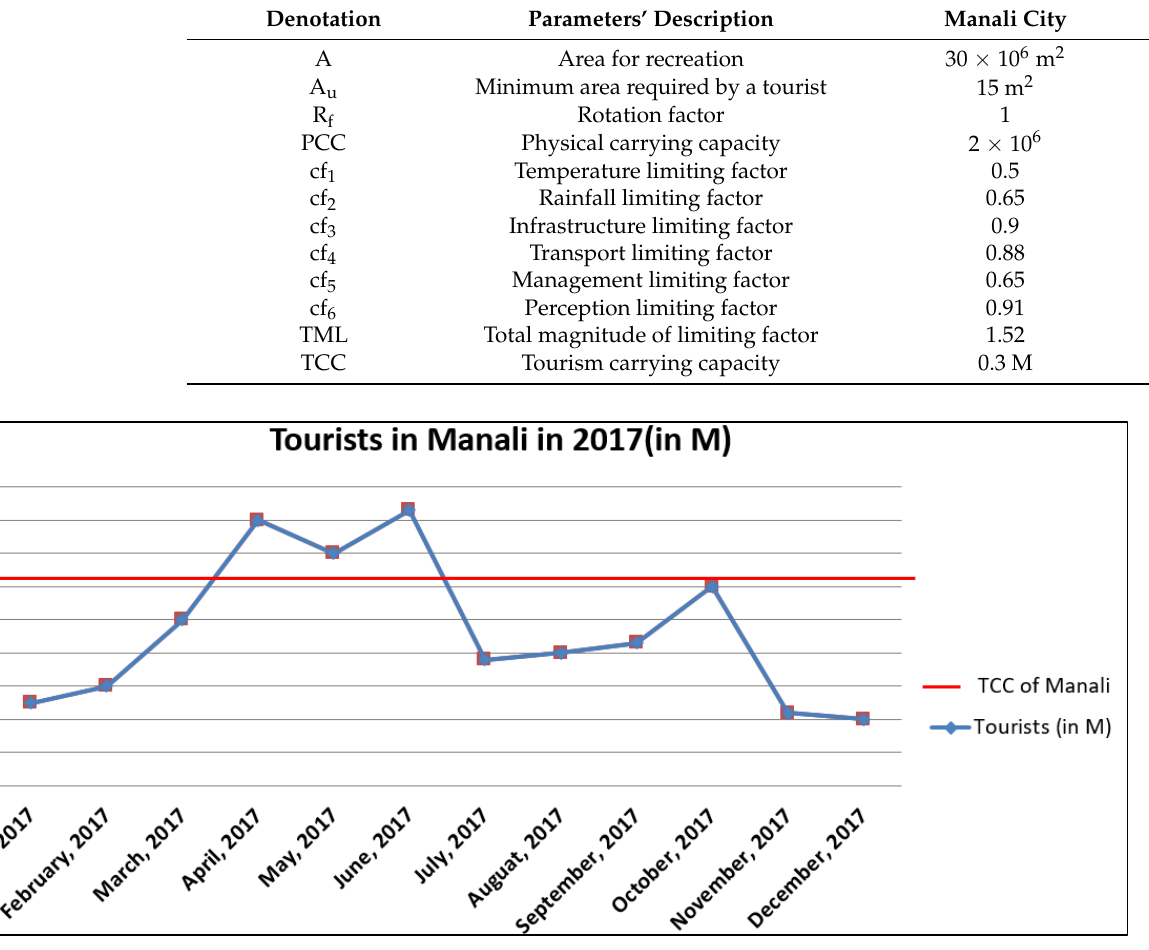
Figure 5. Comparison of monthly tourism (2017) with TCC in Manali. Table 6. Estimation of Tourism Carrying Capacity of Manali.